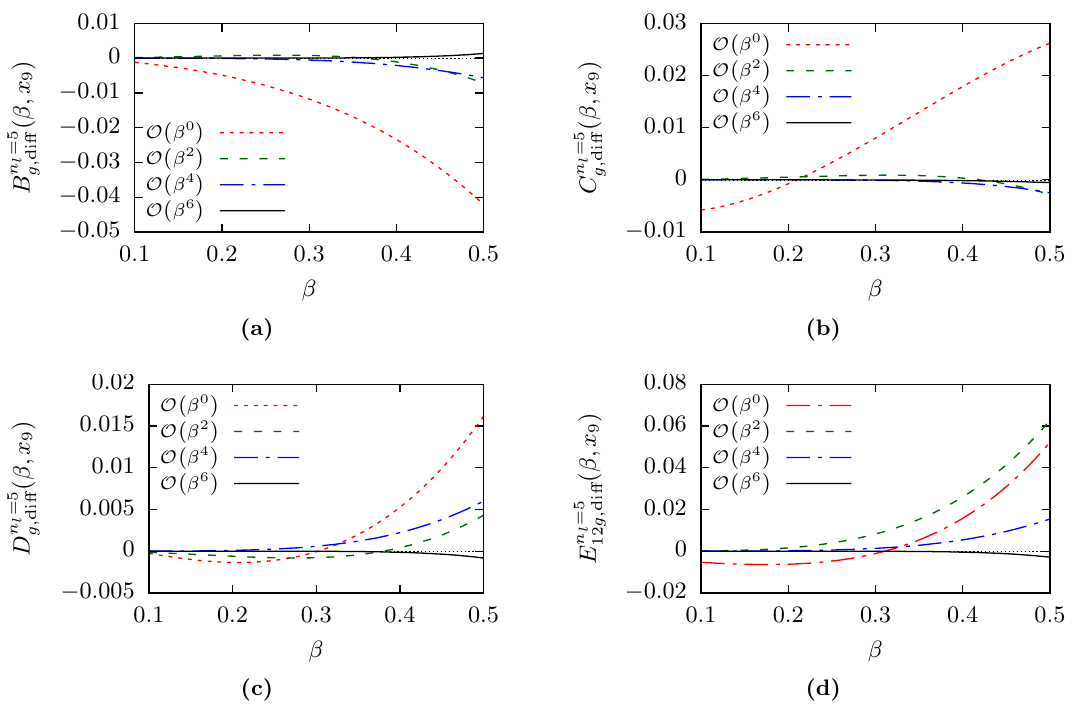
Figure 5 . The di(cid:11)erence between the threshold expansion for coe(cid:14)cient B g ; C g ; D g ; E 12 g up to (cid:12) n with n = 0 ; 2 ; 4 ; 6 and results from numerical integration for a (cid:12)xed angle (cid:18)